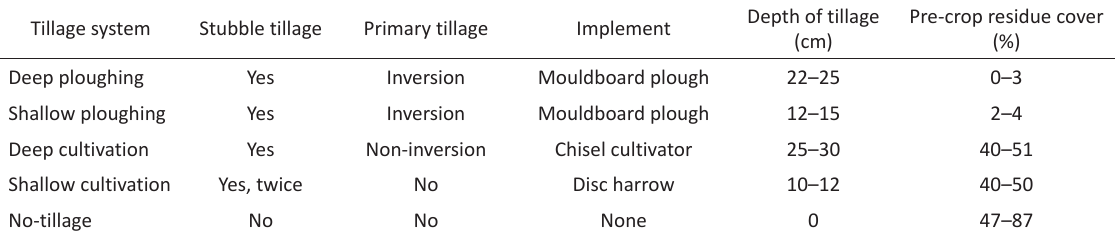
Table 3. Tillage practice in the experiment (according to Romaneckas et al. 2017) Tillage system